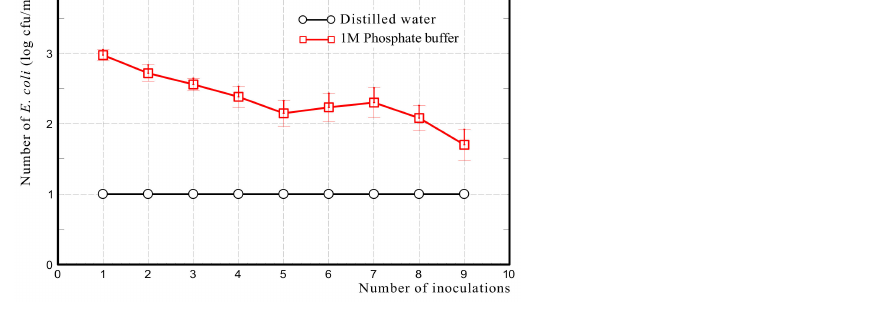
Figure 19. Number of E. coli (log cfu/mL) released from Akahoya after the addition of 1 M phosphate buffer or distilled